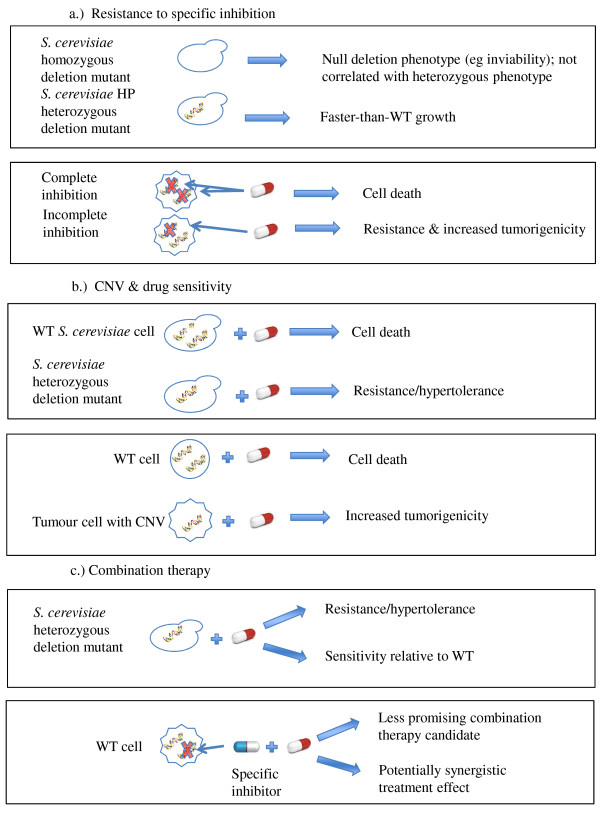
The relevance of haploproficiency and hypertolerance to drug interventions. a) specific inhibition, but not complete protein-product ablation, of an HP target prompts increased growth; b) case where the cancer cell itself bears a CNV of an HP gene, the deletion mutant phenotype may better predict cancer cell drug response; c) case where the deletion mutant for a specific gene is hypertolerant to a compound inhibiting a distinct target, a combination therapy of the same compound plus an inhibitor of the first gene is unlikely to elicit a positive therapeutic response.